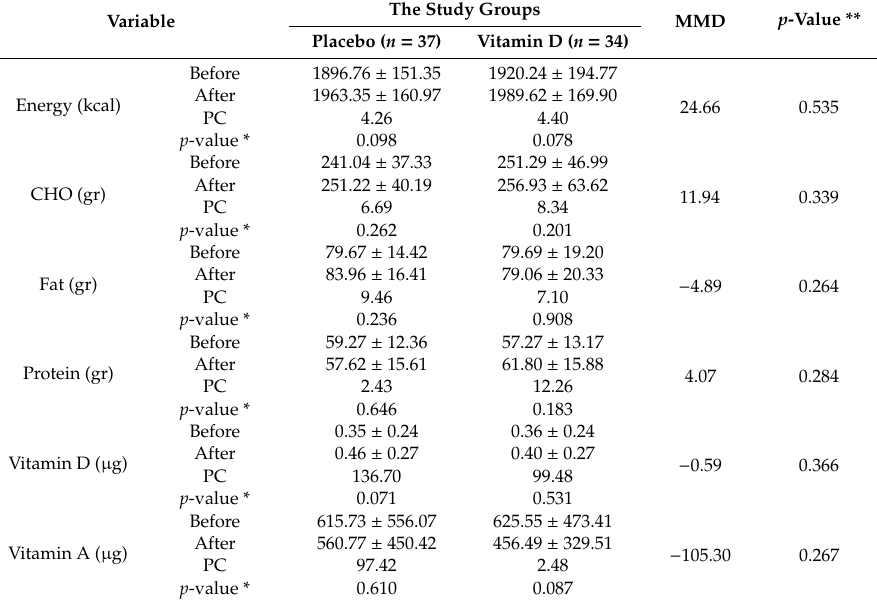
Table 2. Comparing the energy and nutrient intakes per day before and after the intervention between study groups.